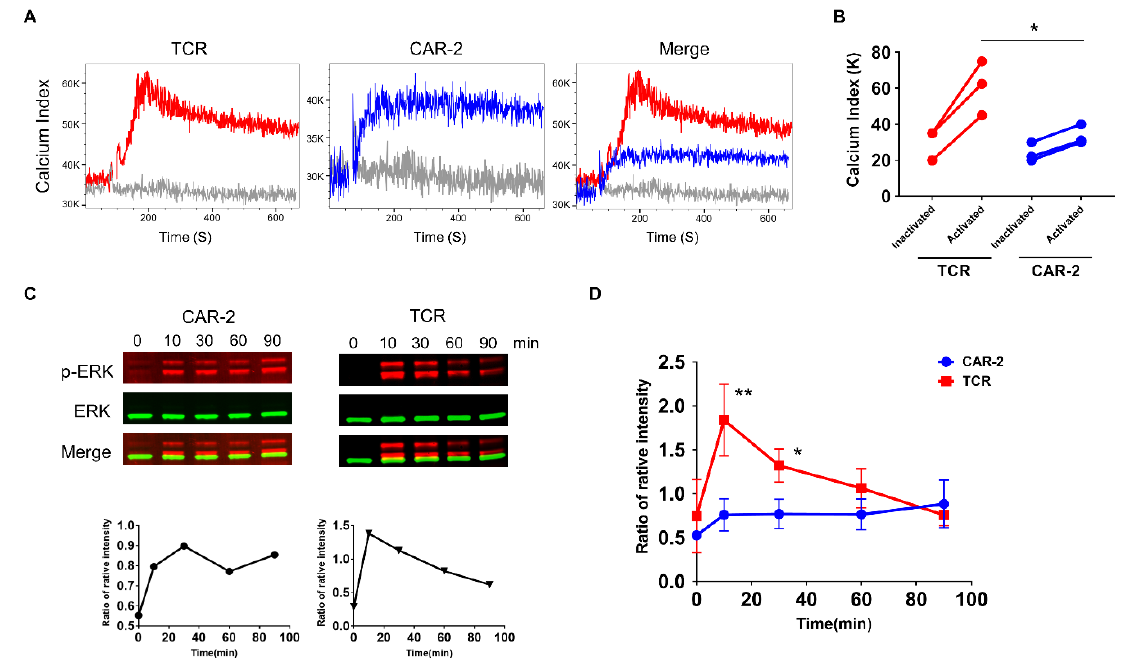
Figure 2. Sustained CAR and TCR signaling kinetics by Ca 2+ flux and downstream phosphorylation. ( A ) Long-term Ca 2+ flux of CAR and TCR signaling. The Ca 2+ flux was recorded for 10 min after the tetramer was added. Calcium index was calculated as the ratio of BUV395/Indo-1 (UV). The negative control, shown in grey, was from after adding PBS. ( B ) Quantification data of TCR and CAR Ca 2+ flux. Activated data dots indicate the highest value of the Ca 2+ flux from TCR or CAR samples. ( C ) Phosphorylation of the ERK molecule of CAR and TCR after stimulation at different timepoints. Phosphorylation strength of pERK1/2 was calculated by comparing the intensity of p-ERK to that of total ERK. The two graphs are then grouped to compare their intensity strength; Uncropped Western Blots are available in Figure S3. ( D ) Quantification data of p-ERK of TCR and CAR-Jurkat cells after activation. All data are representative of at least three independent experiments. Student’s t test, two-tailed, was used to measure the significance; * p < 0.05, ** p < 0.01.